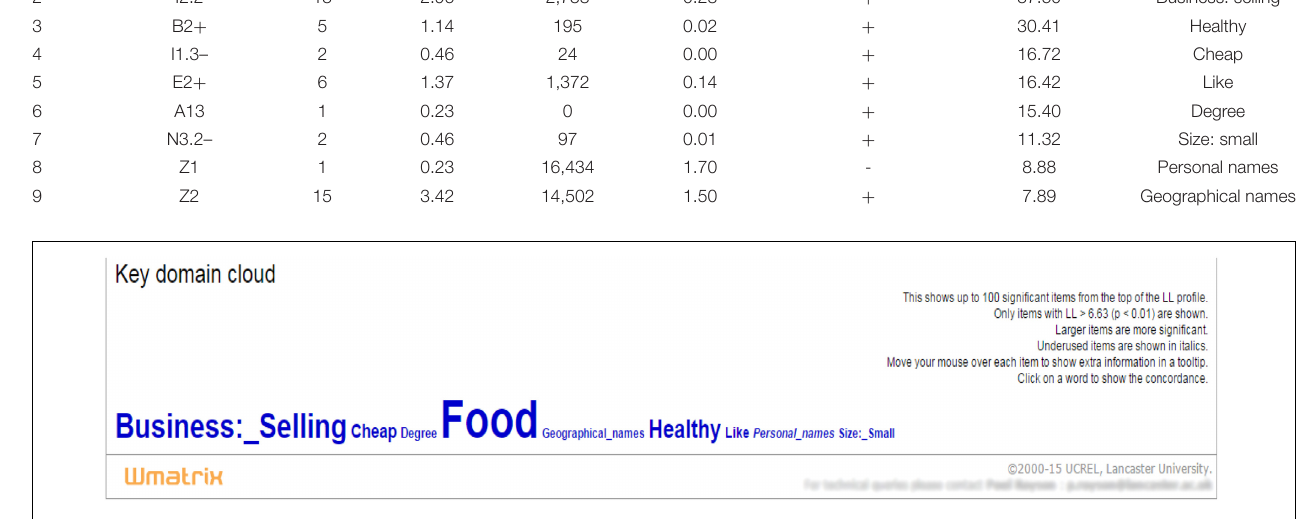
FIGURE 1 | Key semantic domains for the text, Fast Food Invasion